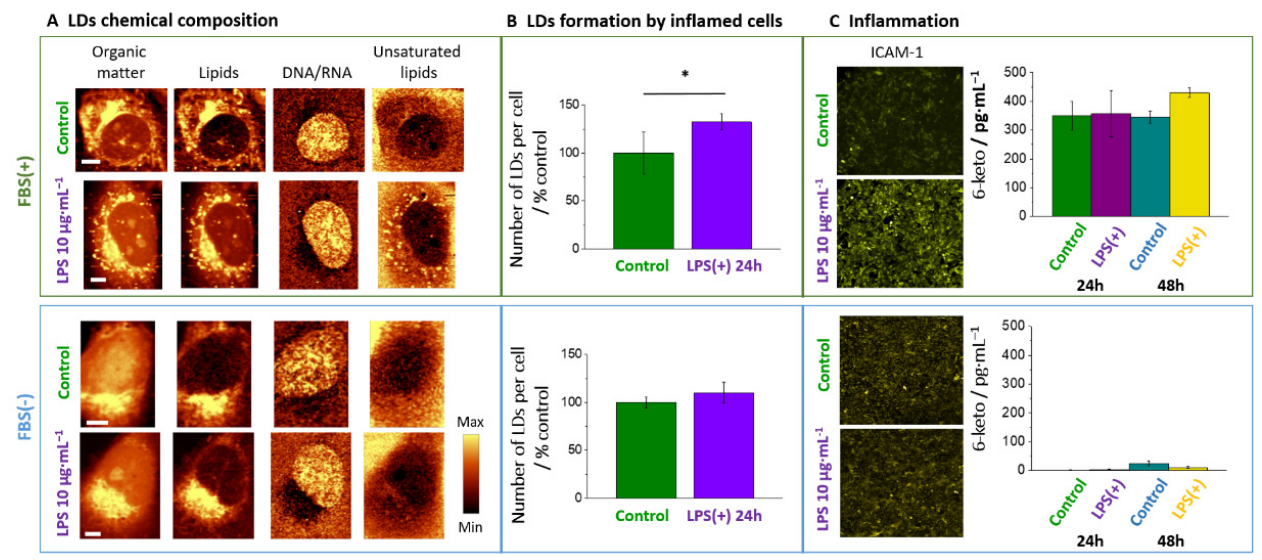
Figure 7. LPS-induced response of endothelial cells in the presence and absence of FBS. In the presence but not in the absence of FBS, LPS-induced LD formation rich in unsaturated lipids ( A , B ) was directly related to inflammation manifested as increased ICAM-1 expression and elevated 6-keto PGF 1 α level ( C ). * p < 0.01.